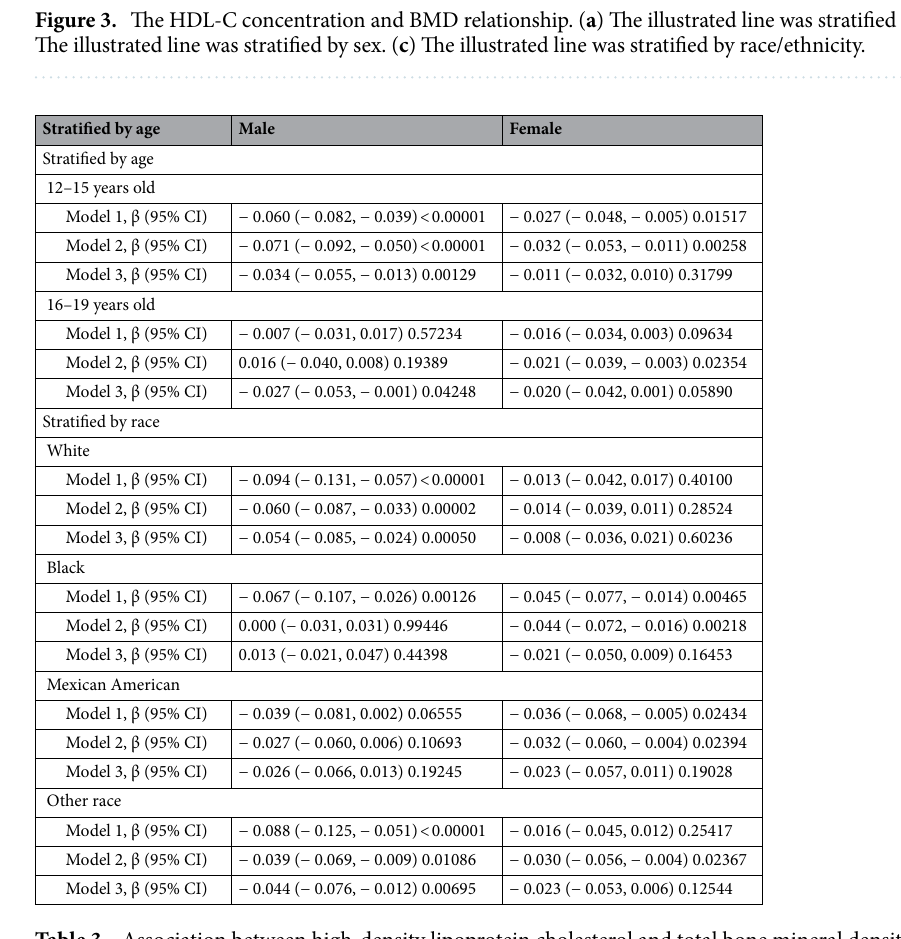
Table 3. Association between high-density lipoprotein cholesterol and total bone mineral density stratified by gender, age, and race. Model 1: No adjusted. Model 2: Age and race were adjusted. Model 3: All covariates were adjusted. The stratification variable itself was not adjusted in the subgroup